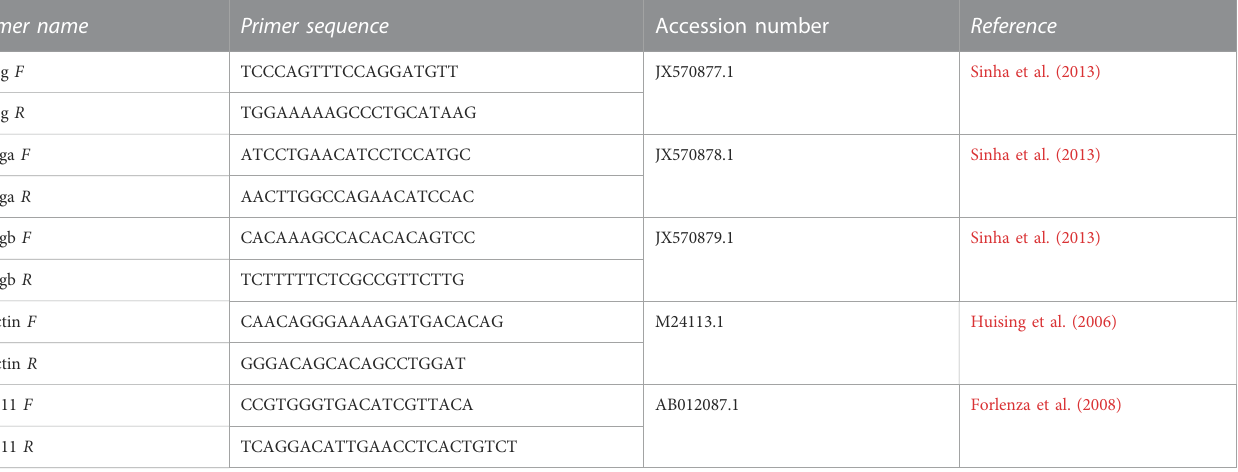
TABLE 2 Primer sequences used for gene expression studies of carp